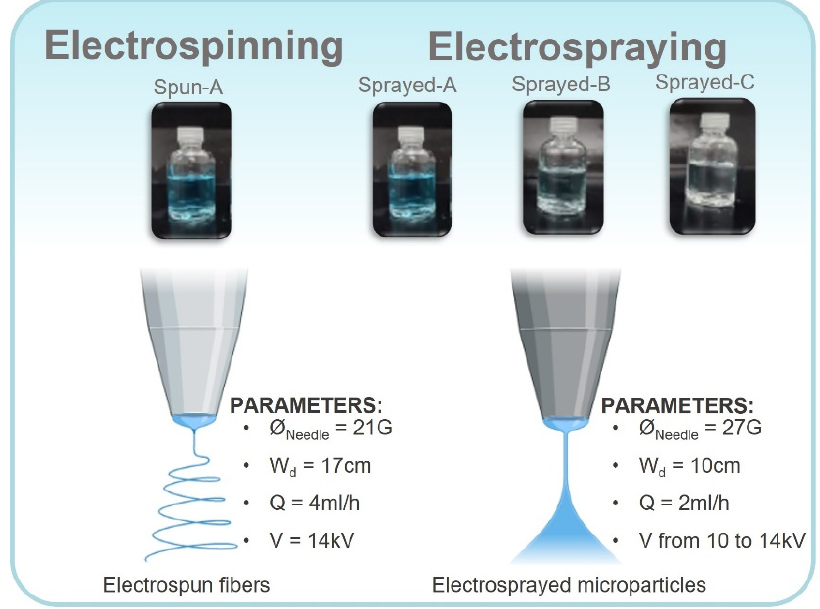
Figure 1. Methodological scheme showing the prepared PVP-copper salt solutions and the electrospinning and electrospraying parameters. Adapted from “Electrospinning instrumental” and “Electrospray emitter” by BioRender.com (accessed on 13 September 2022).